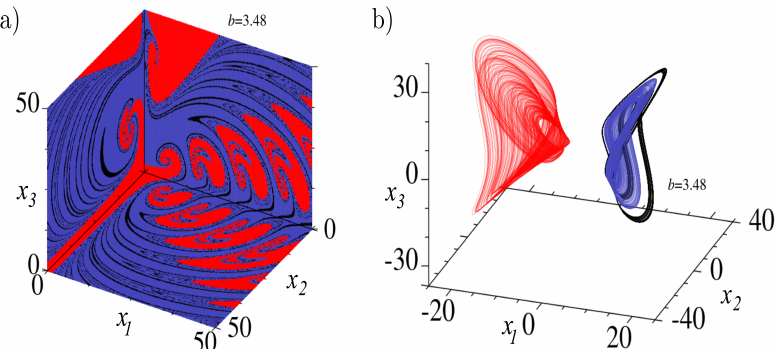
Figure 3. ( a ) Intersections of the basins of attraction of Equation (2) with the planes x 10 = 0, x 20 = 0 and x 30 = 0. For the parameter value b 22 = 3.48, the system presents three stable chaotic attractors, depicted in ( b ).